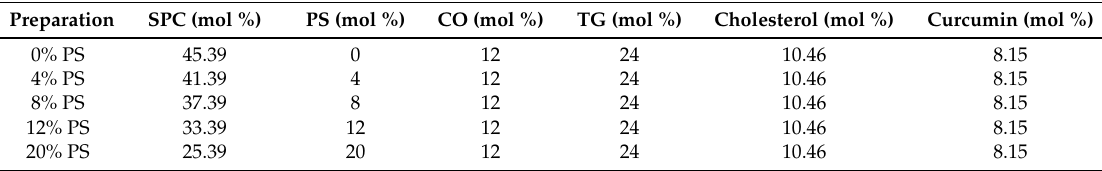
Table 3. Preparation of different PS-containing